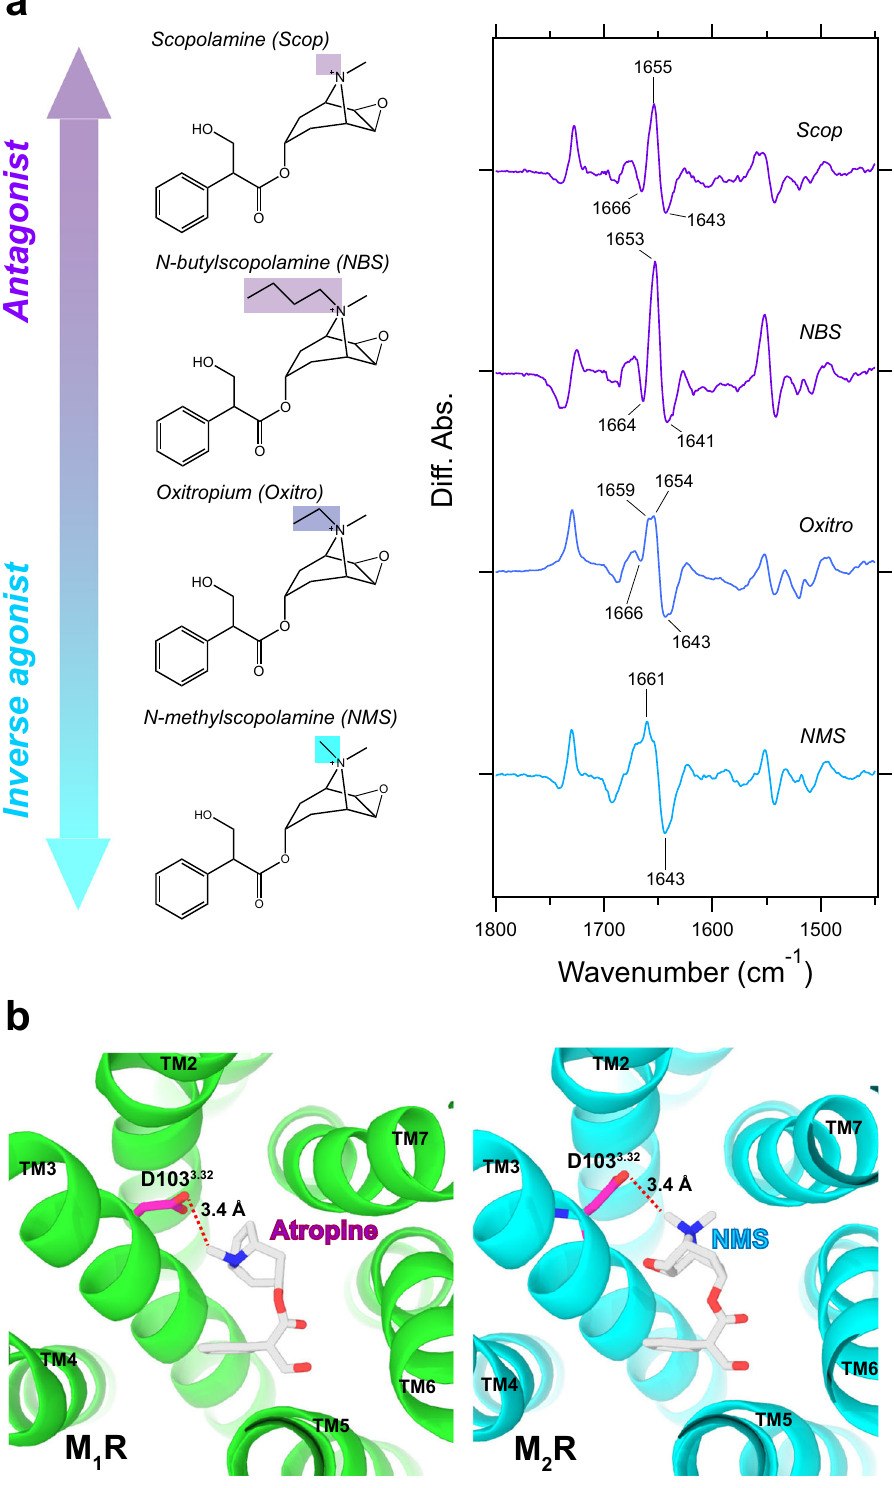
Fig. 6 Comparison between the scopolamine derivatives. a Chemical structures of the scopolamine derivative ligands (Scopolamine (Scop), N -butylscopolamine (NBS), Oxitropium (Oxitro), and N -methylscopolamine (NMS)) used in the current FTIR spectroscopic studies, and each ligand bound spectra in the 1800 – 1450cm − 1 region. The group of quaternary ammonium derivative positions are highlighted. Ligand binding-induced difference ATR-FTIR spectra are measured in H 2 O at 293K. Positive and negative bands correspond to ligand-bound and ligand-unbound states, respectively. One division of the y - axis corresponds to 0.0025 absorbance unit. b Comparison between Atro-bound structure in M 1 R (green, PDB: 6WJC) 47 and NMS-bound structure in M 2 R (cyan, PDB: 5YC8) 15 at the view from extracellular side. The amino acid residues and ligands are depicted by sticks, and TM helices are depicted by ribbons. Hydrogen bond between Asp103 3.32 and amine group of both ligands are shown by red dotted lines with hydrogen bond length as